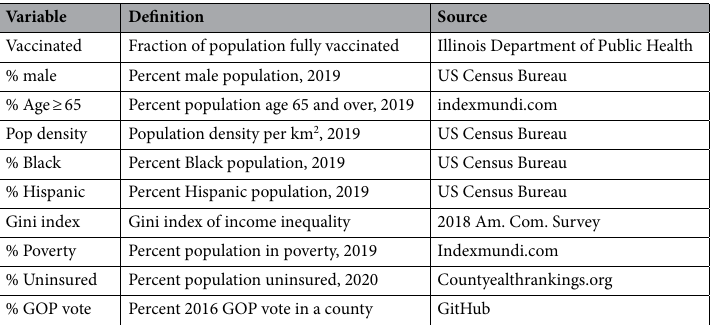
Table 1. The data sources of the 102 Illinois